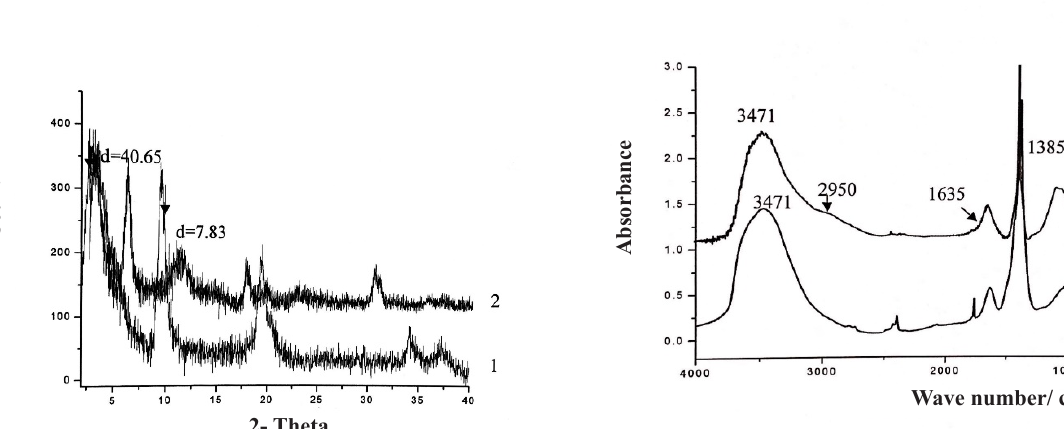
Figure 1.b: FTIR spectra of (1) Mg/AlNO 3- LDH (2) Trypsin adsorbed on Mg/ AlNO 3-